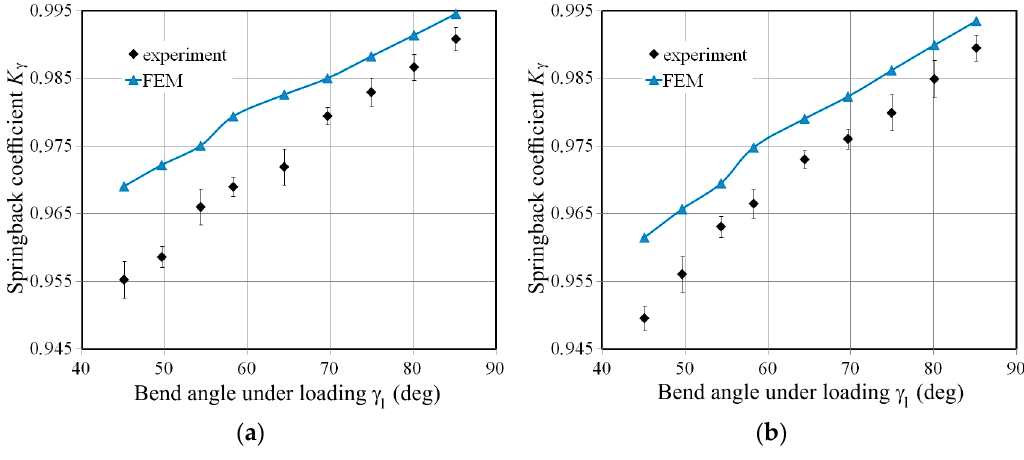
Figure 7. Comparison of the springback coefficient value determined experimentally and by the FEM approach (Gauss’ quadrature, five integration points) for samples oriented according to ( a ) the rolling direction (0°) and ( b ) transverse to the rolling direction (90°).